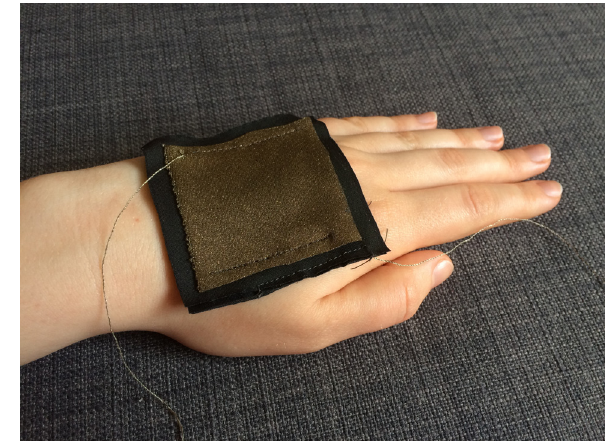
Figure 1: The prototype robot companion for children with autism that was presented to the therapists in our interview study. It is an NAO robot ( SoftBank Robotics ) ; the NAO robot shown on the left is wearing a thin fabric shirt, and the one on the right is enclosed in a soft koala suit.